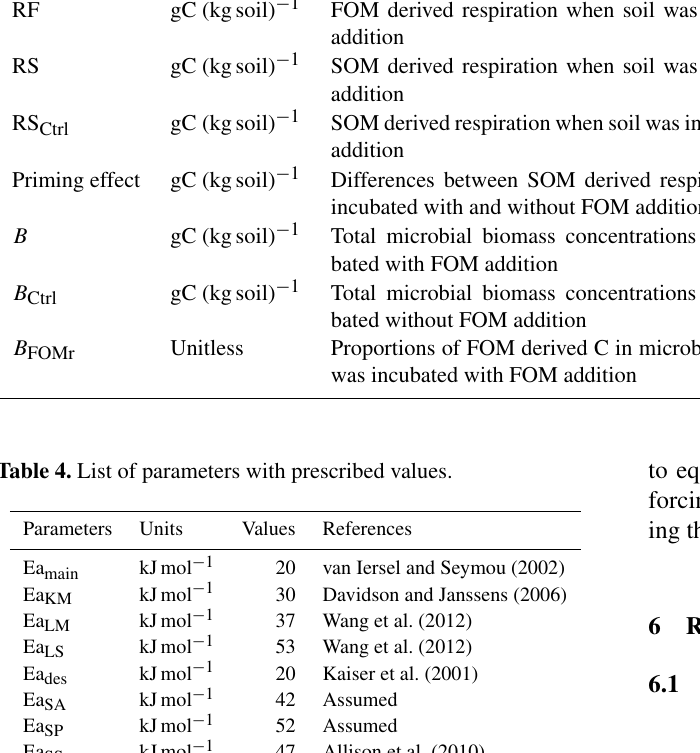
Table 3. List of the observed variables used for optimization. Variables